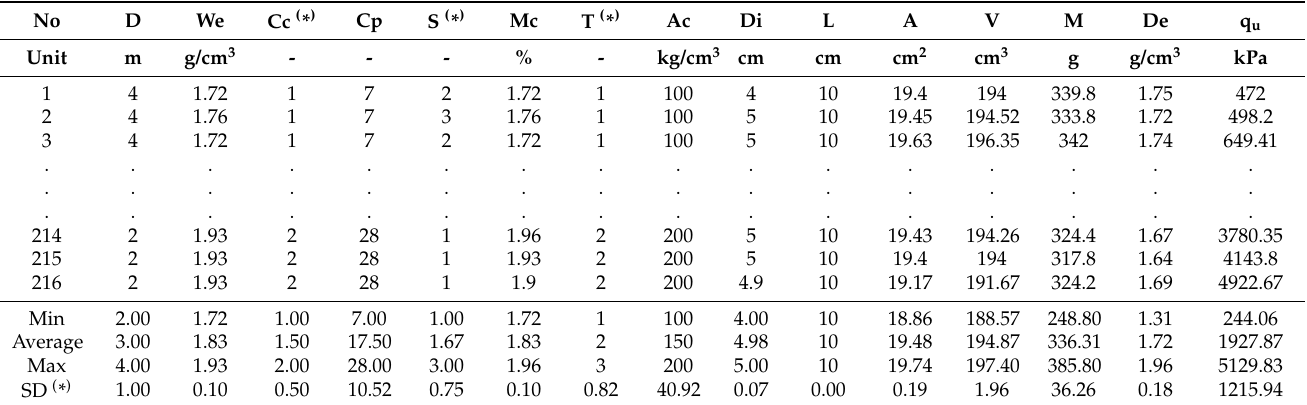
Table 1. Inputs and output of the present